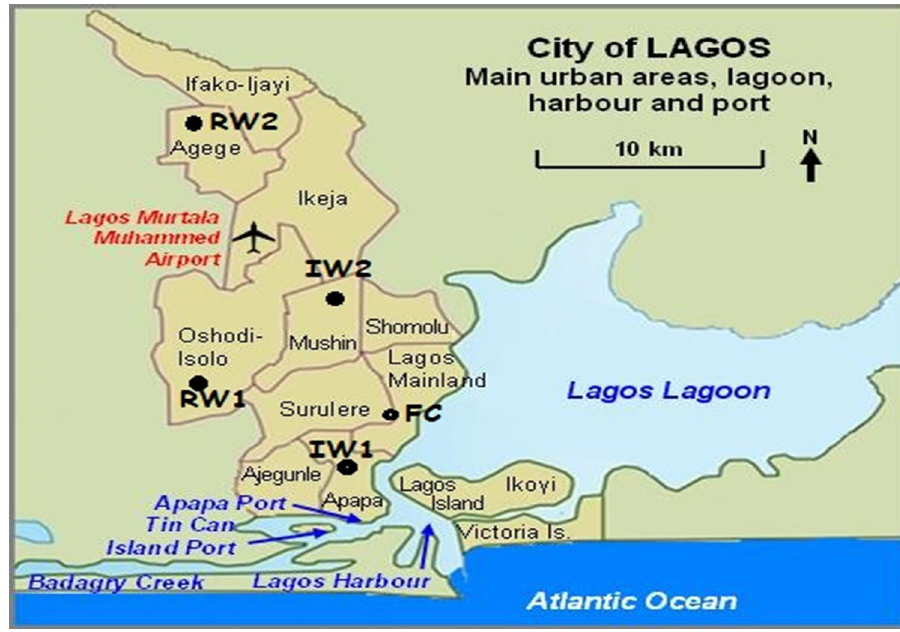
Fig. 1 Map of Lagos showing sample